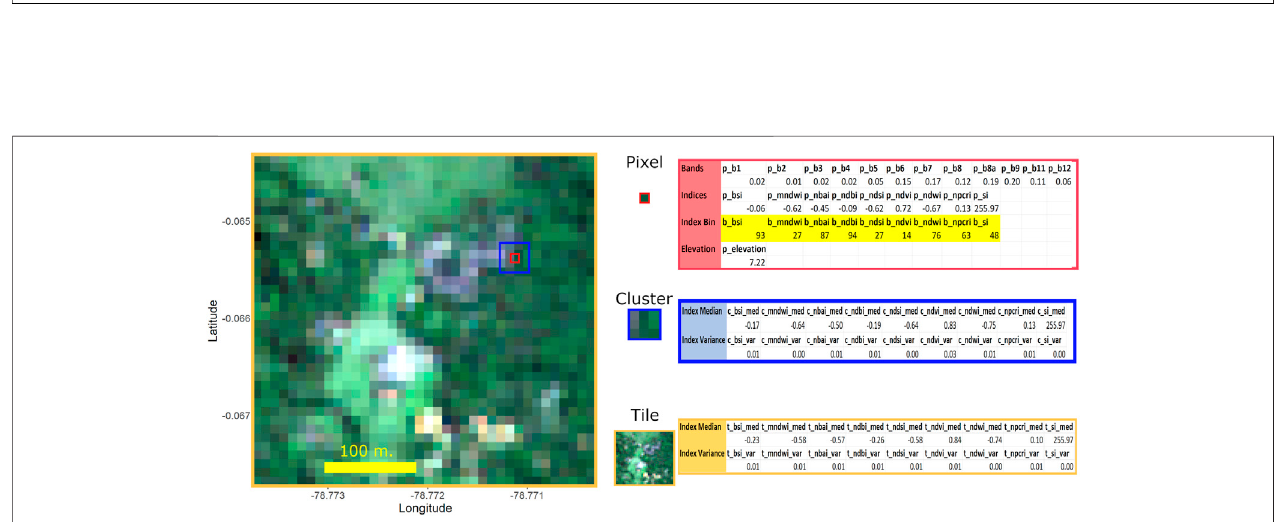
FIGURE6| Therasteraboveisthesameonefeaturedin Figure1D .Foreachpixel(suchastheoneaboveenclosedwithinaredsquare),wedevelopedpredictors at three spatial scales: the individual pixel; the cluster of nine adjoining pixels; and all pixels within the tile. At the pixel-level, predictors consist of the 12 normalized band values;9rasterindices;andthelogarithmoftheelevationlevel.Atthecluster-level,wetookthemedianandvarianceforeachrasterindexacrosstheninepixelswithinthe cluster. At the tile-level, we took the median and variance of each index across all pixels within the tile.